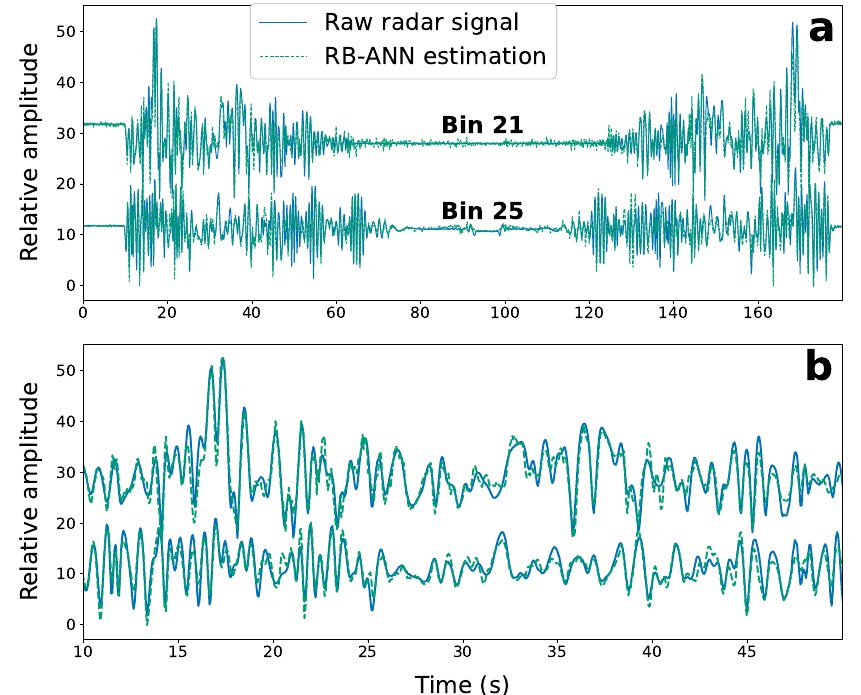
Figure 7. RB-ANN estimated noise (dashed green line) in two target range bins compared with the radar-measured noise (solid blue line) in those bins in the absence of RMP-simulated breathing for the entire duration of data collection ( a ), and for the interval between 10 s and 50 s ( b ).